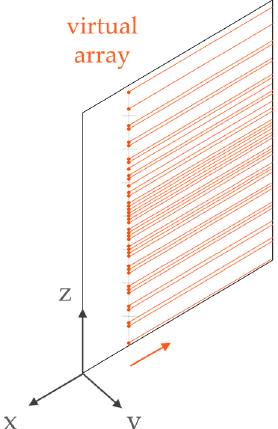
Figure 5. Scheme of the resulting scan geometry in case of the CS array in the vertical direction.